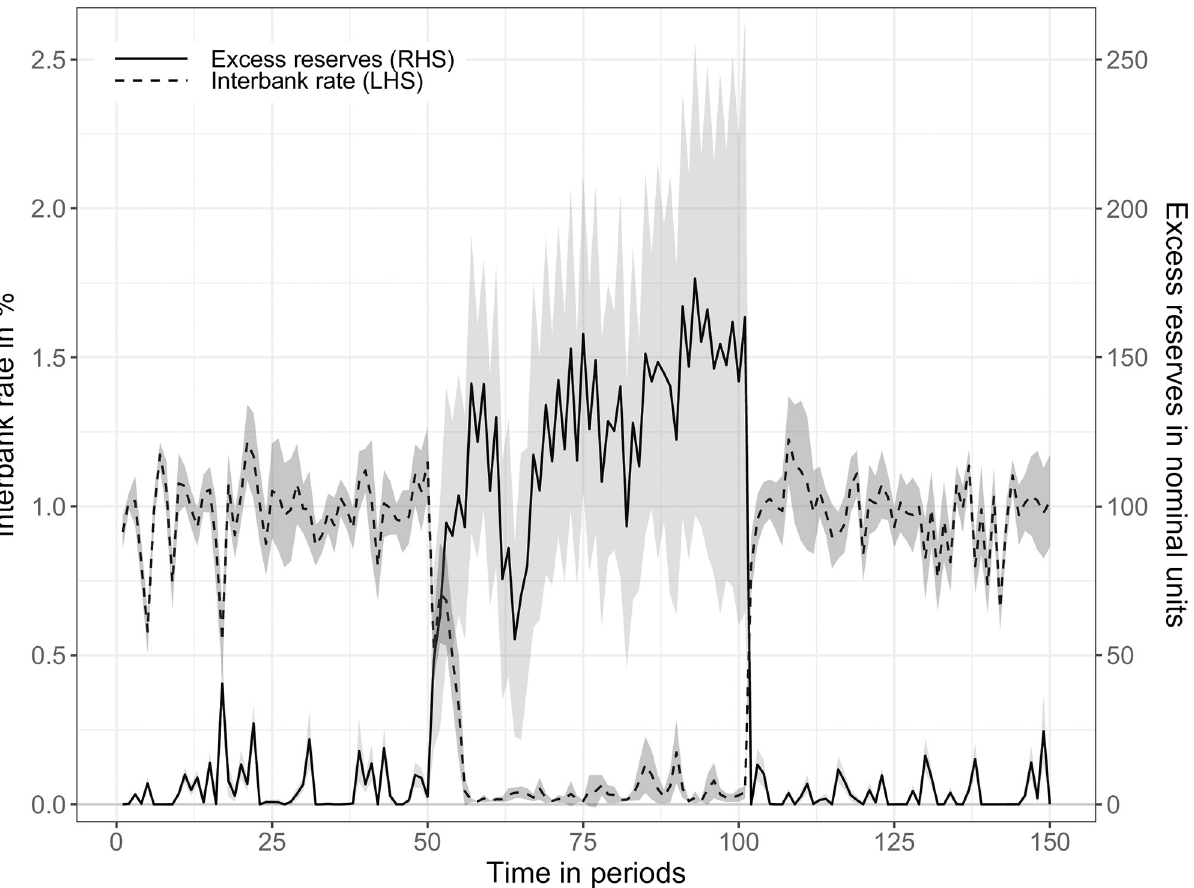
Fig 14. SF13: Interbank market. Note: The Figure depicts average interbank rate as a dashed line and excess reserves as a solid line. The simulation output is a representative run with an interbank experiment between period 50 and 100. The grey shaded area represents the 90% confidence interval.